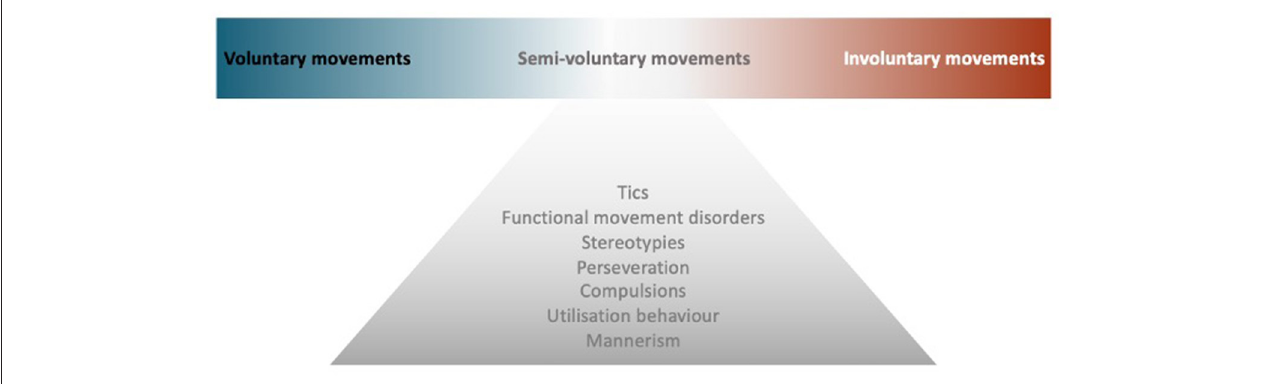
FIGURE 1 | Model of semivoluntary movement. A diagram illustrates the concept of semivoluntary movement which is the neurological conditions in the borderland between voluntary and involuntary